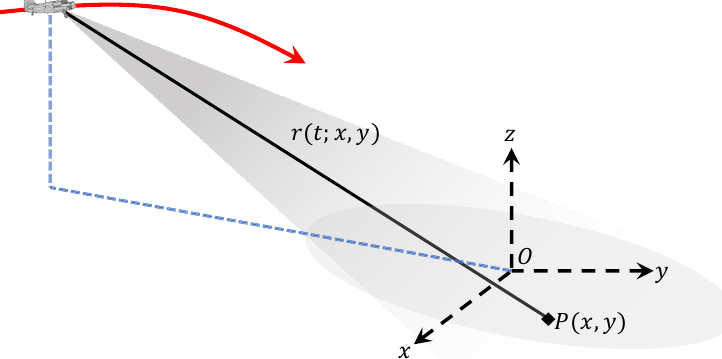
Figure 2. Geometry configuration of highly squinted SAR with curved